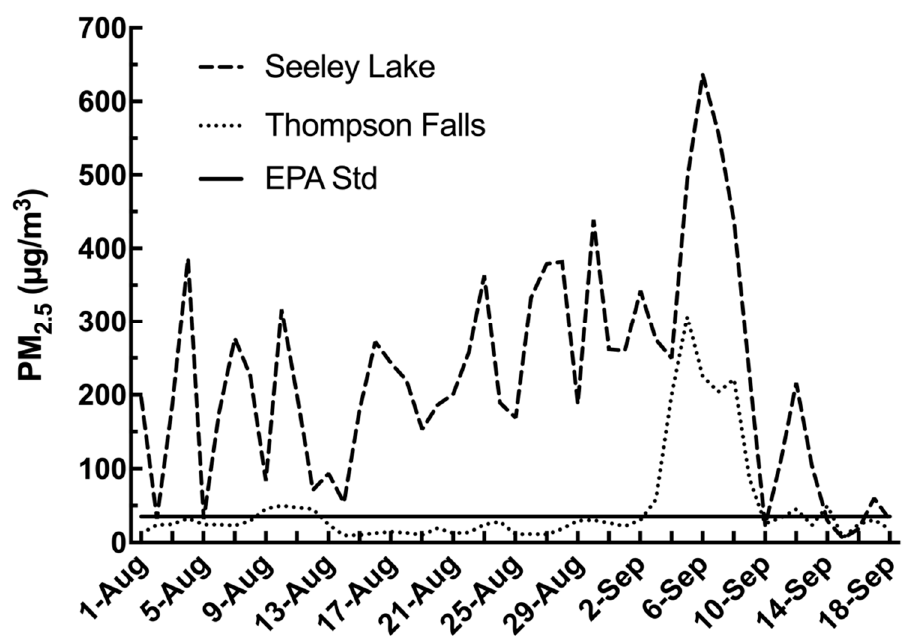
Figure 1. PM 2.5 levels in two western Montana communities during 2017 fires. The above graph illustrates the PM 2.5 levels during the peak wildfire time period for Seeley Lake and Thompson Falls. As can be seen, 2017 levels Seeley Lake were significantly above the NAAQS daily target of 35 μ g/m 3 for almost the entire period with an average of 220.9 μ g/m 3 . In comparison, while Thompson Falls PM 2.5 levels followed a similar trend and the overall daily average was 47 μ g/m 3 , a large portion of the period saw daily levels below the